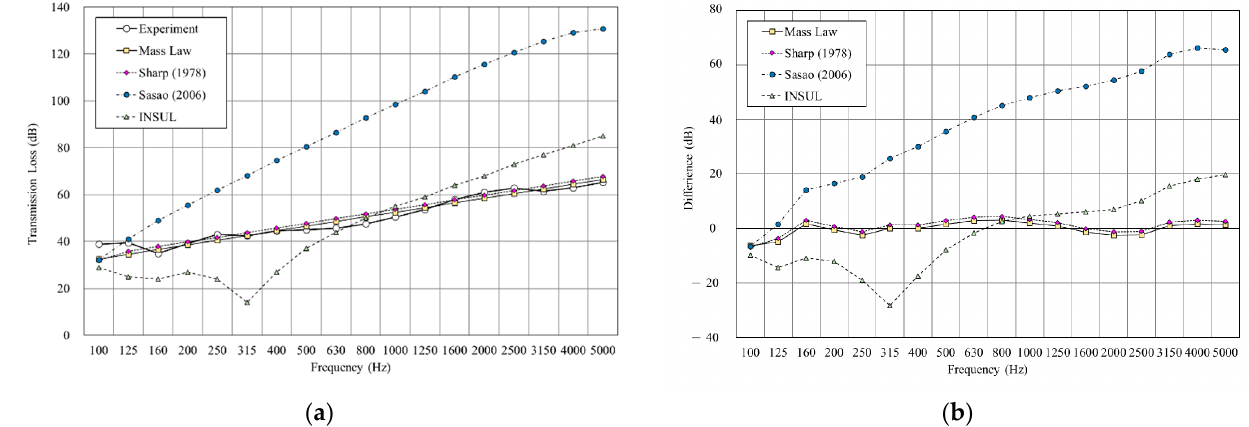
Figure 9. Comparison between experimental and predicted results of the double wall with 25 mm cavity (B1). ( a ) The sound insulation performance of experiment and prediction. ( b ) The RMSE results of different prediction models.